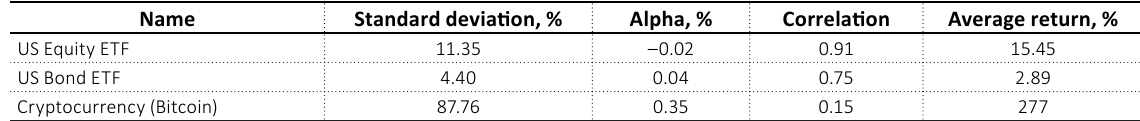
Source: Authors’ calculation.